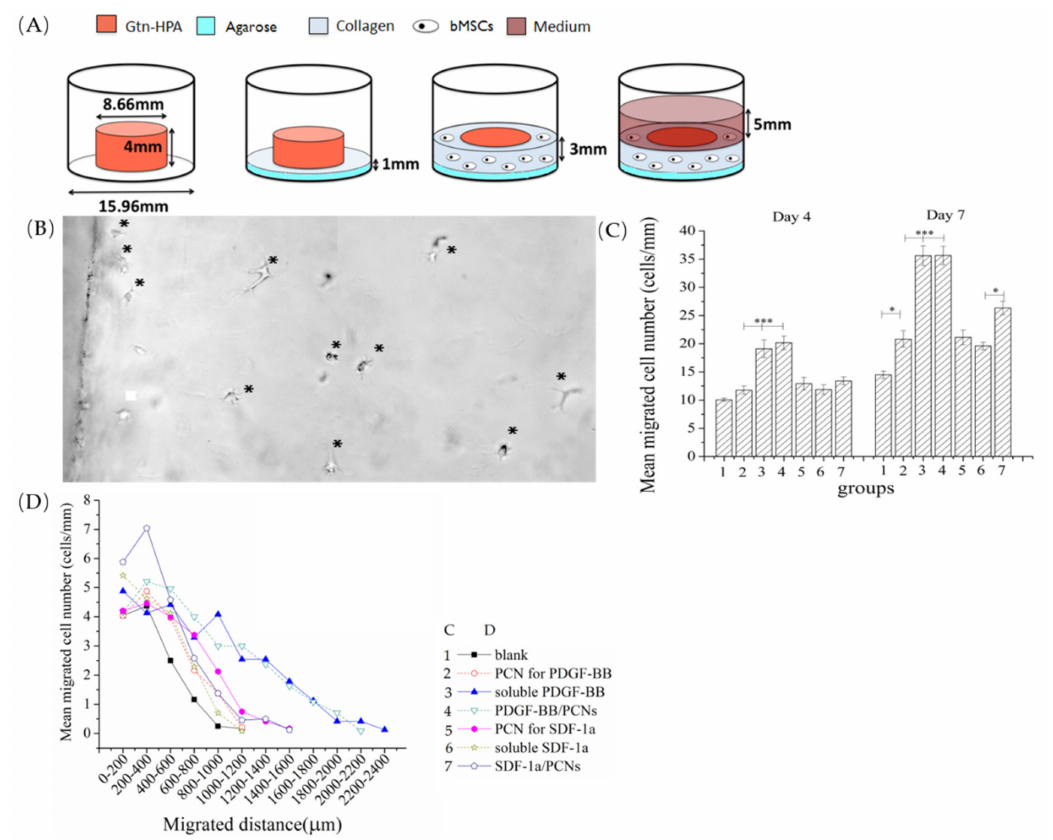
Figure 5. ( A ) Annulus-core migration model. ( B ) A typical migration micrograph on day 4; asterisks show bMSCs. ( C ) Migrated cell numbers/mm of interface in each group. ( D ) Migration distance on day 7 (* p < 0.05; *** p <